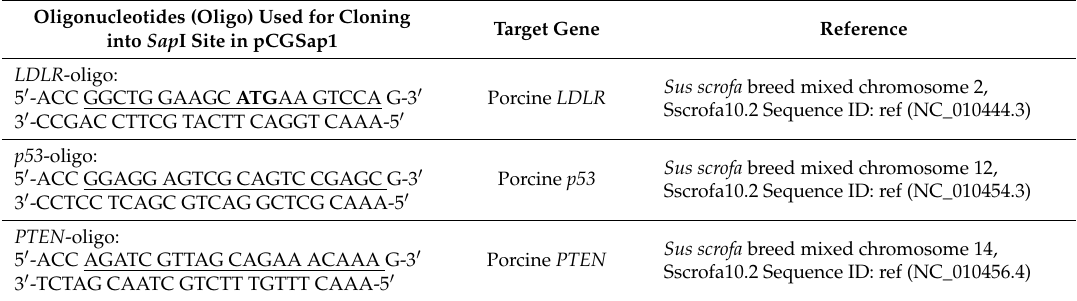
Table 1. Information on sgRNA used for the construction of pCGsap1/LDLR, pCGsap1/p53, and pCGsap1/PTEN.